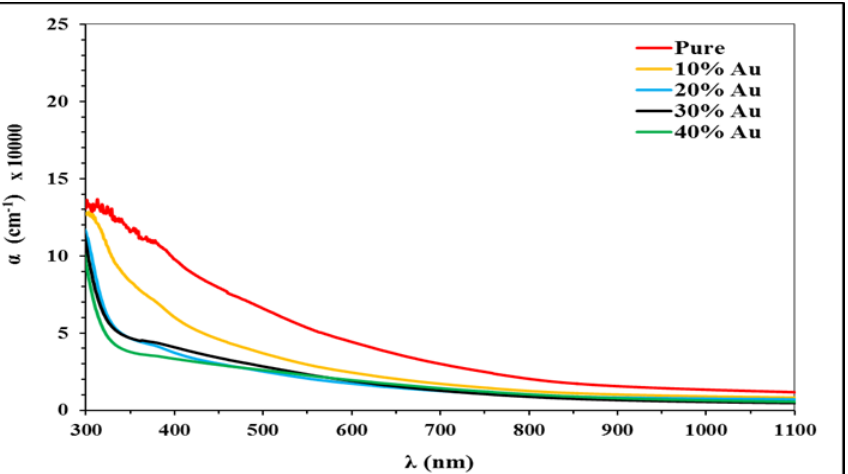
Fig.8: The absorption coefficient for pure WO a function of wavelength at T